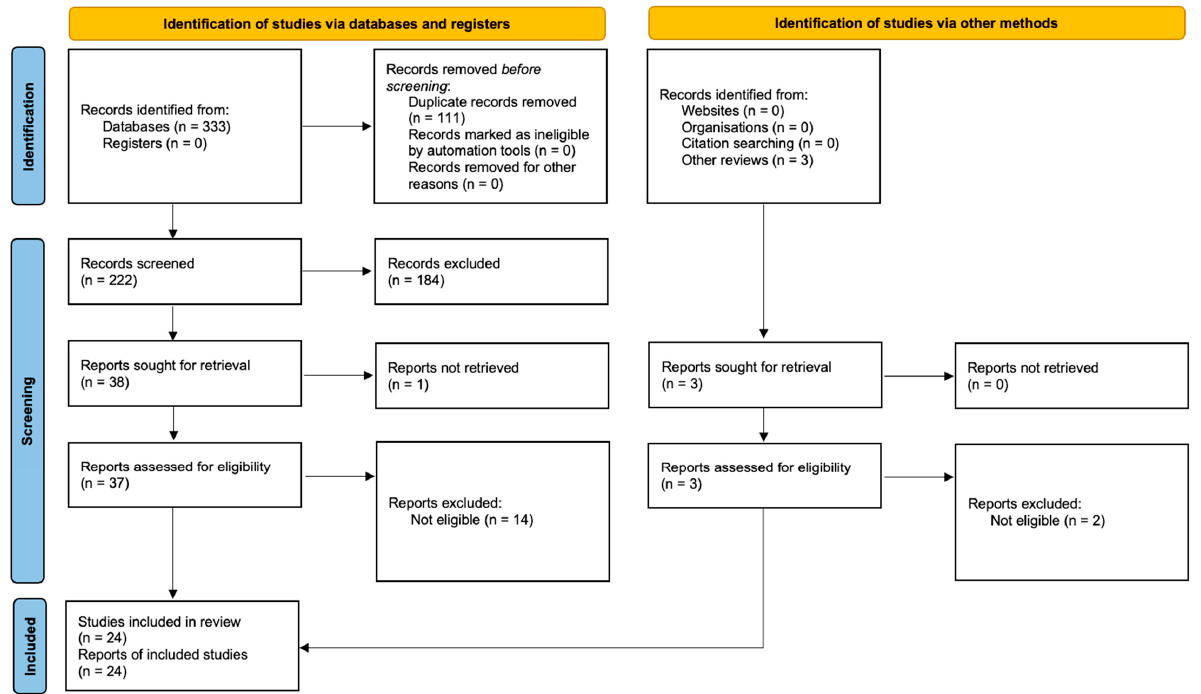
Figure 1. Modified Prisma Flow Diagram [54] for the observational studies on gut microbiome changes in patients with major depressive disorder included in the systematic review.